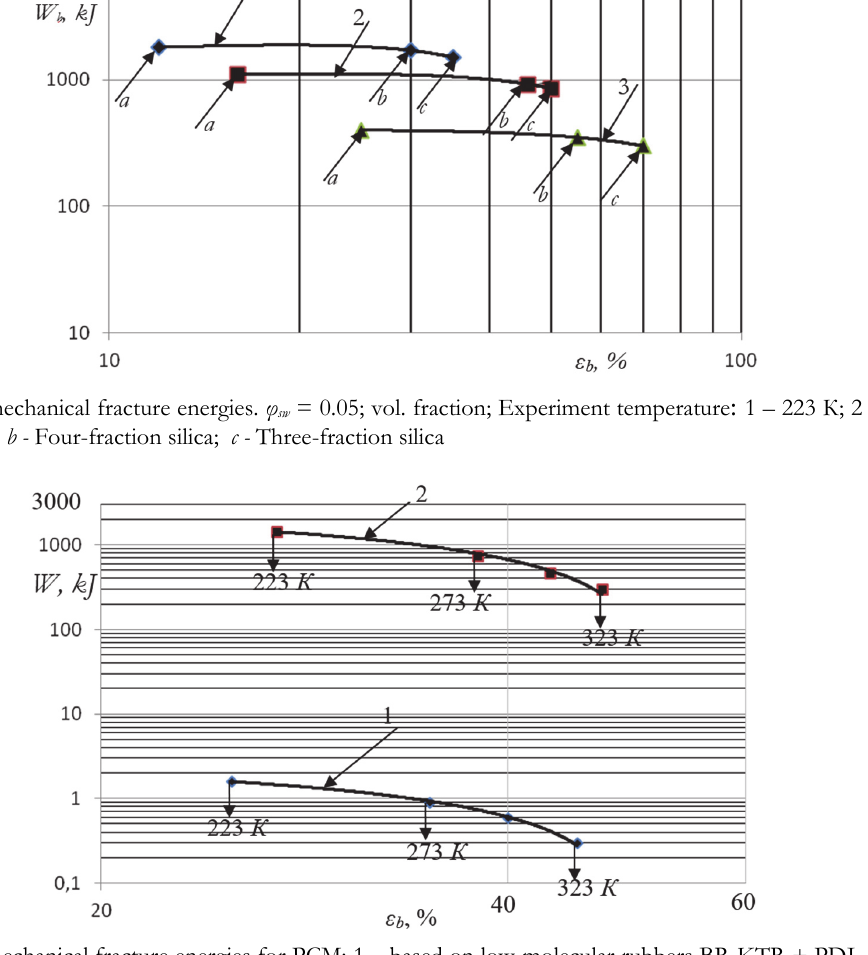
Figure 4: Envelopes of mechanical fracture energies for PCM: 1 – based on low-molecular rubbers BR-KTR + PDI- 3B; 2 – based on high-molecular rubbers IR +